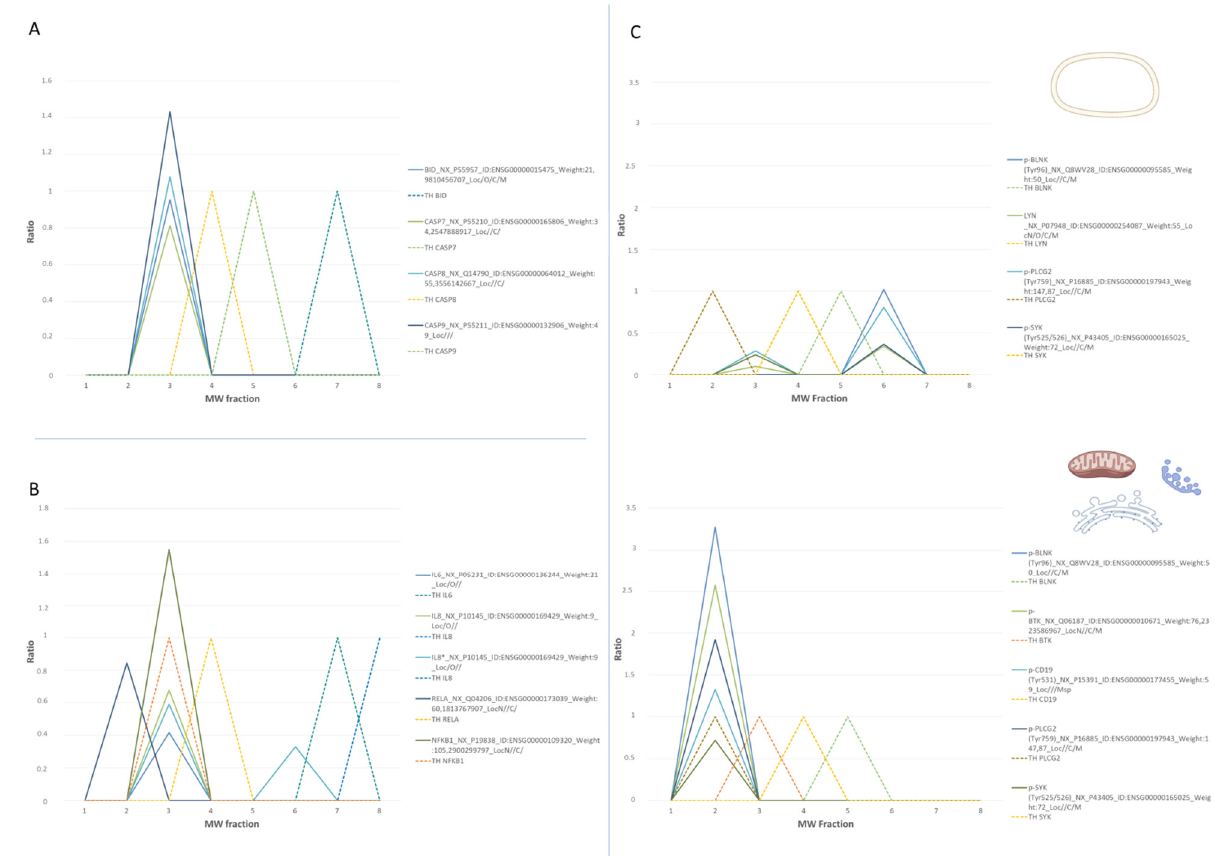
Figure 5. Multiprotein complex by SEC-MAP approach. Analysis of chosen multicomplexes involved in several cell signaling processes. ( A ): Proteins related to apoptosis inhibition. ( B ): Protein related to STING signaling. ( C ): Proteins related to B-cell receptor signaling in membrane and organelle subcellular localizations.